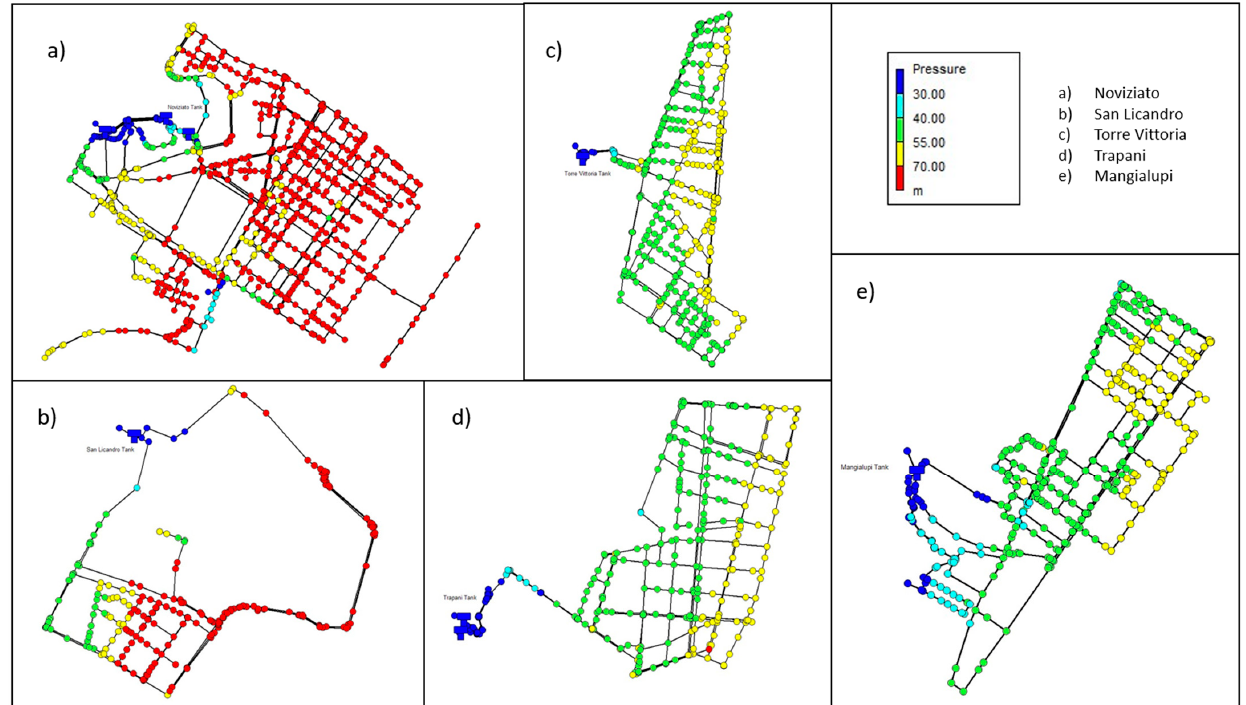
Figure 5. NPR for Messina WDN in Scenario 2 for the following districts: ( a ) Noviziato; ( b ) San Licandro; ( c ) Torre Vittoria; ( d ) Trapani; ( e ) Mangialupi. Table 3. SI values for each district in Scenario 2 after partitioning.